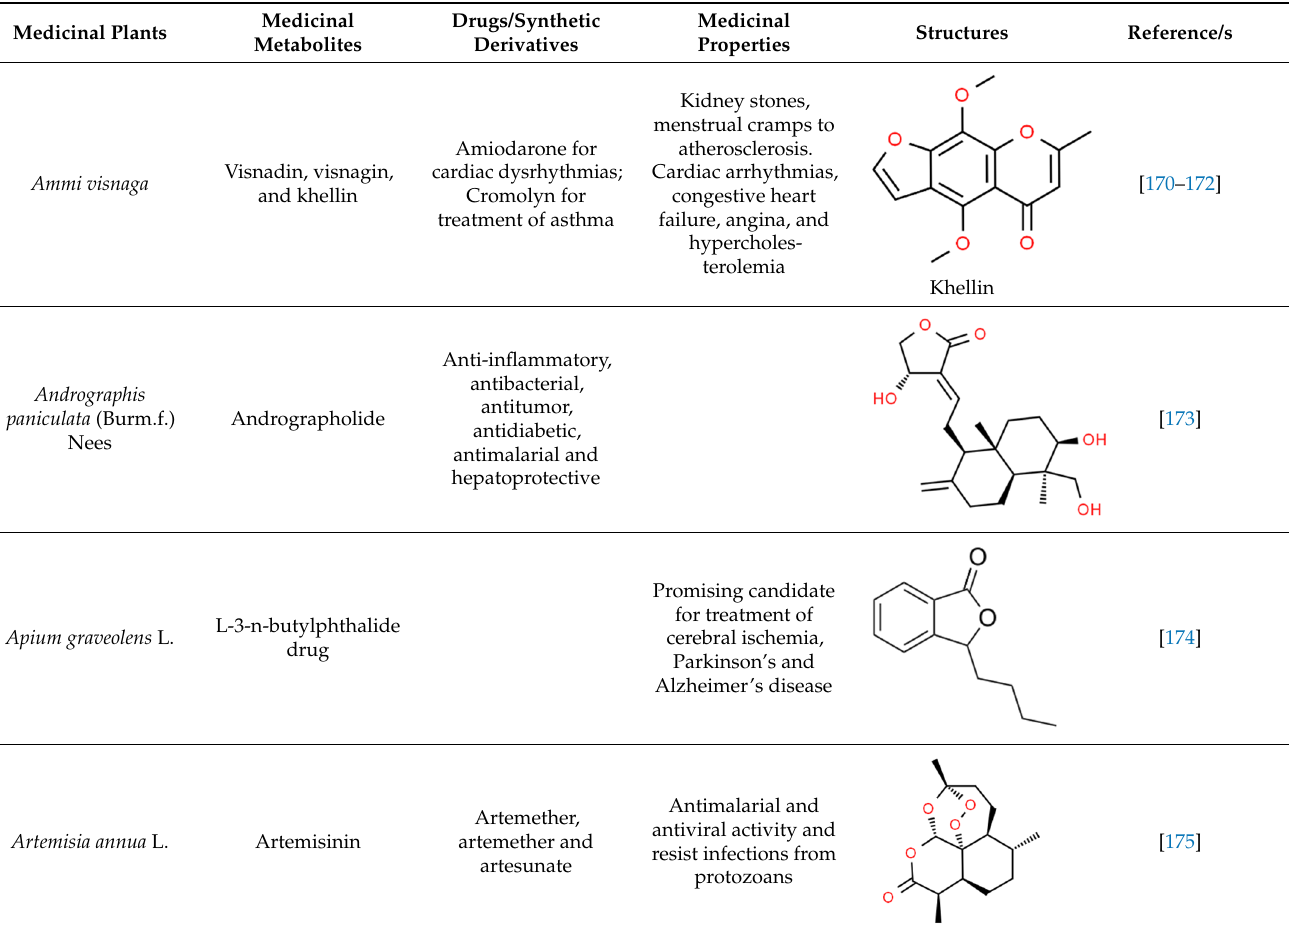
Artemisia annua L.